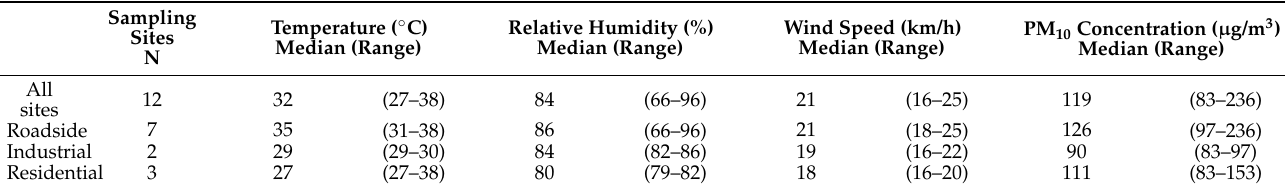
Table 1. Environmental and meteorological characteristics for the three types of site (roadside, industrial and residential) from which ambient air was sampled in urban Accra, Ghana (February 2020).